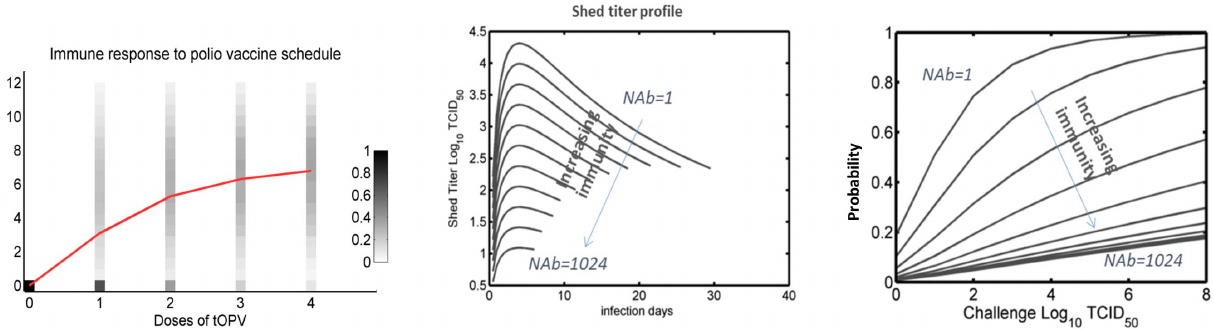
Figure 1. Behavior of the polio model. ( A ) Distribution of mucosal immunity by number of OPV doses given to a previously naı¨ve individual. The depth axis in figure represents the probability distribution of antibody titer in the stochastic model and the red line represents the population mean of the antibody titer resulting from the distribution. ( B ) Shedding as a function of initial mucosal immunity and time since infection. ( C ) Probability of infection with different immunity levels and challenge